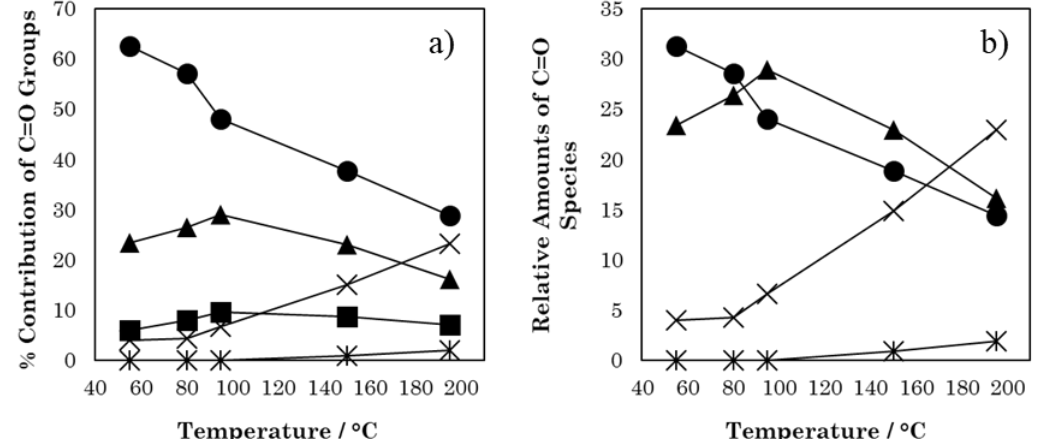
Figure 11. For the CB6OBA:4OS equimolar mixture, temperature dependence of ( a ) the relative areas obtained for the individual carbonyl groups involved in each type of species to the carbonyl stretching region and ( b ) the relative areas obtained for the different carbonyl-containing species to the carbonyl stretching region, scaled by the number of carbonyl groups. ✳ represents monomeric acid species, ✕ asymmetric acid dimers, ⯅ heterocomplexes, ● symmetric acid dimers and ◼ catemers.